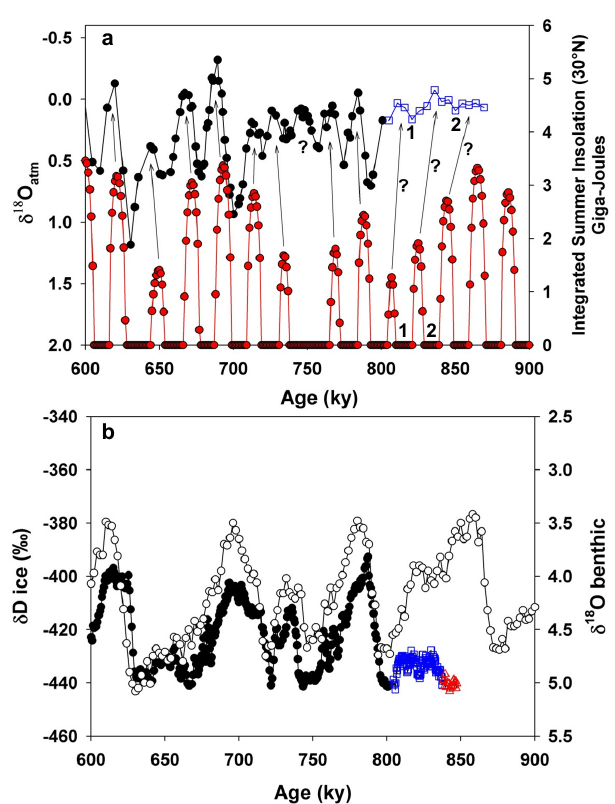
Figure 9. Attempting to reconstruct the timescale for the basal ice sequence: (a) zoom on the δ 18 O atm curve vs. integrated summer insolation at 30 ◦ N (see Fig. 1e) and (b) comparison of the benthic δ 18 O curve (open circles) to the EPICA δ Dice profile (black dots), where the basal ice timescale was linearly “compressed” using tie points 1 and 2 in (a) (see text for